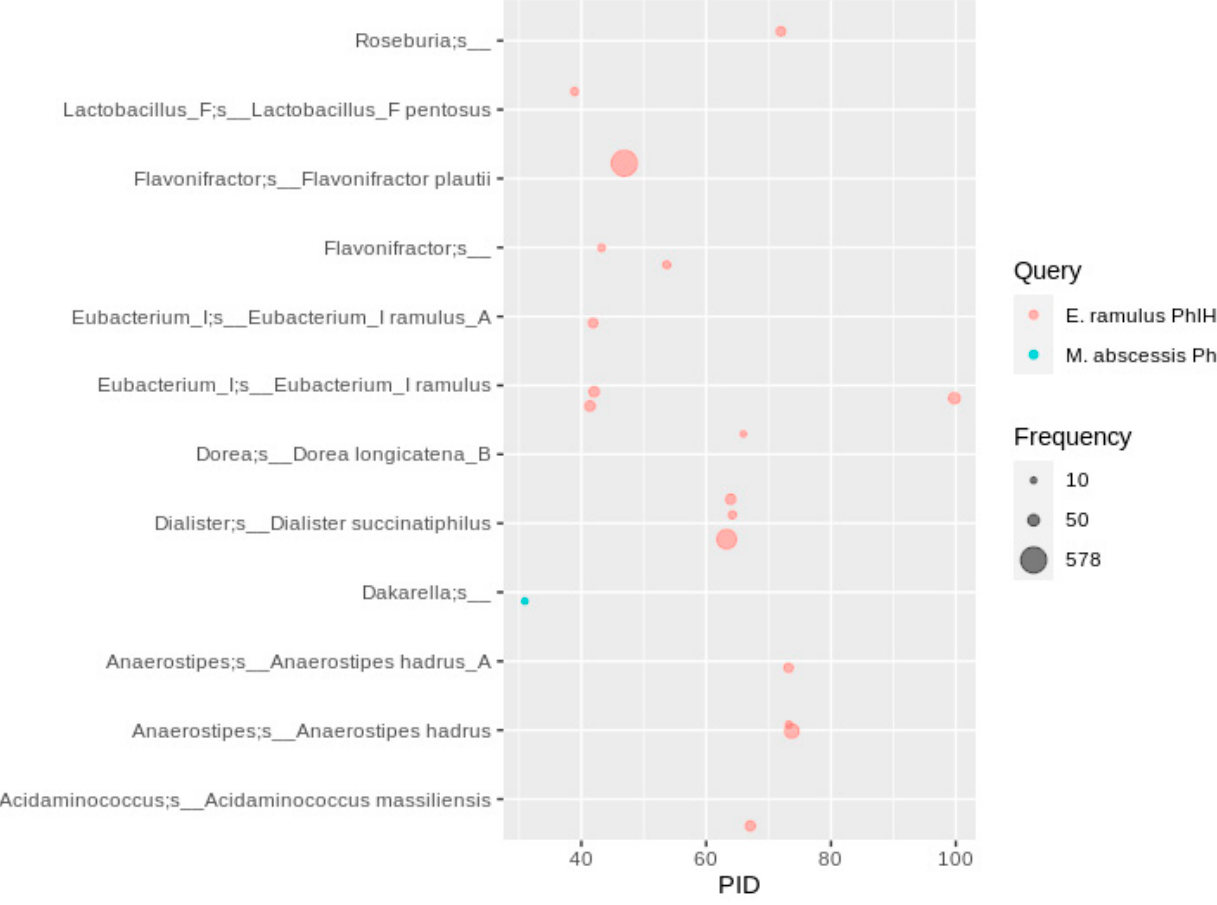
Figure 9. Distribution of Phy homologs in human gut MAGs. Depicted are MAGs with at least five identical amino acid sequences. Hits were filtered for at least ten occurrences, so that each bubble represents a number of redundant sequences ranging from 10 to 578.